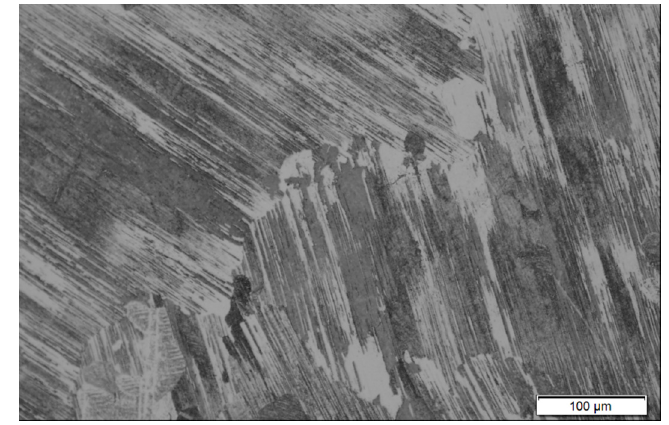
Figure 1. Optical micrograph of the material studied.